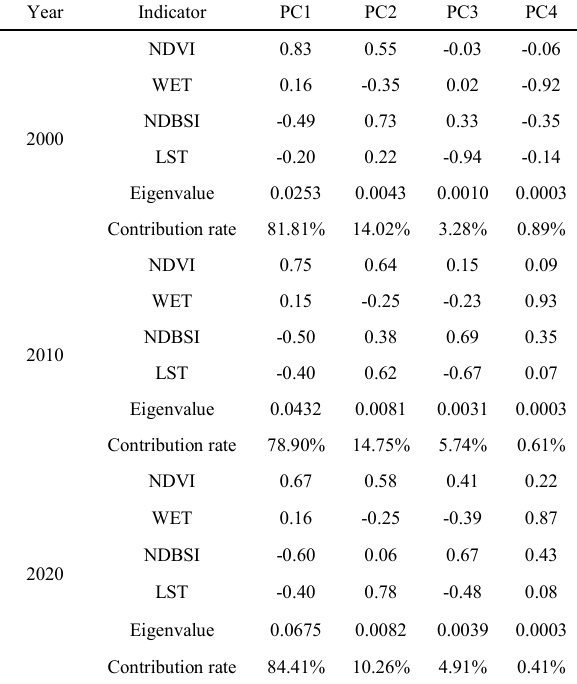
Table 1 . Principal Component Analysis